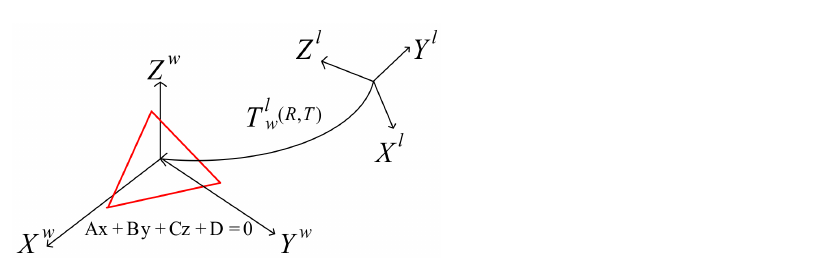
Figure 2. Conversion of world coordinate system to lidar coordinate system. A red triangle is a plane in three